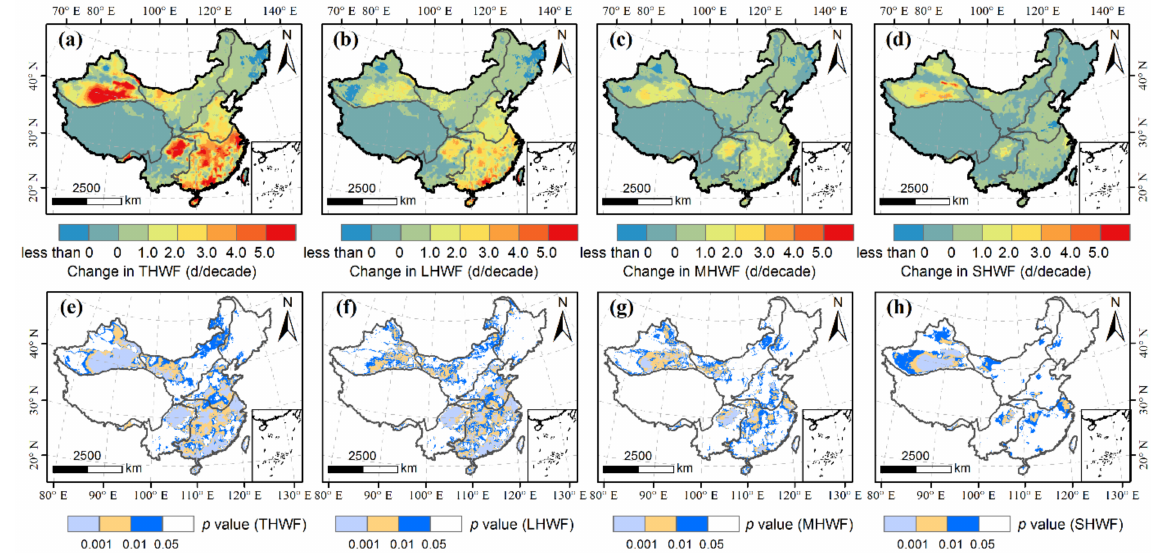
Figure 7. Changes in HWF over China during period 1979–2018. ( a – d ) Change trend in THWF, LHWF, MHWF, and SHWF, respectively; ( e – h ) corresponding p values for HWF, in which p < 0.001, p < 0.01, and p < 0.05 indicate whether corresponding change trend is significant at level of 0.001, 0.01, and 0.05, respectively.